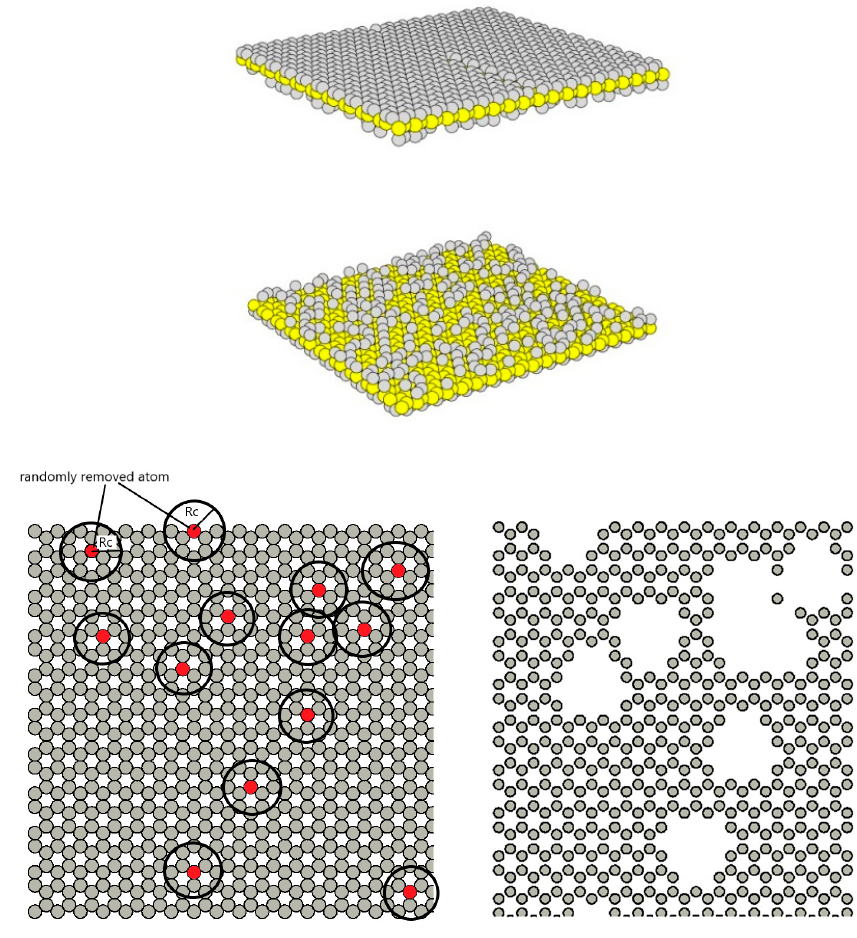
Figure 4. A characteristic of defective surfaces of the porous silica glass model .